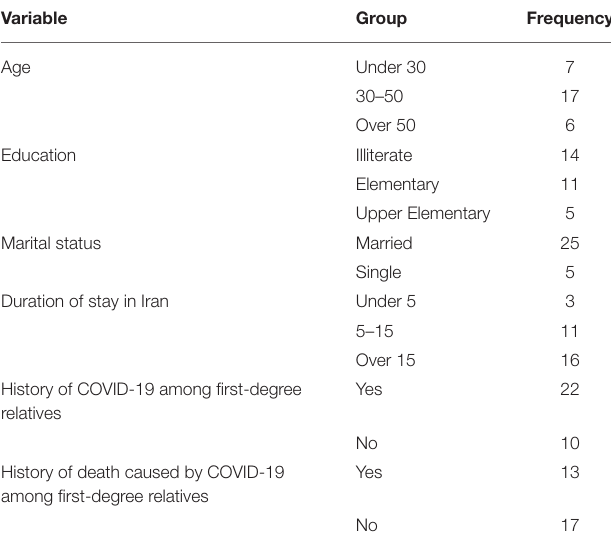
TABLE 2 | Demographic information of participants.